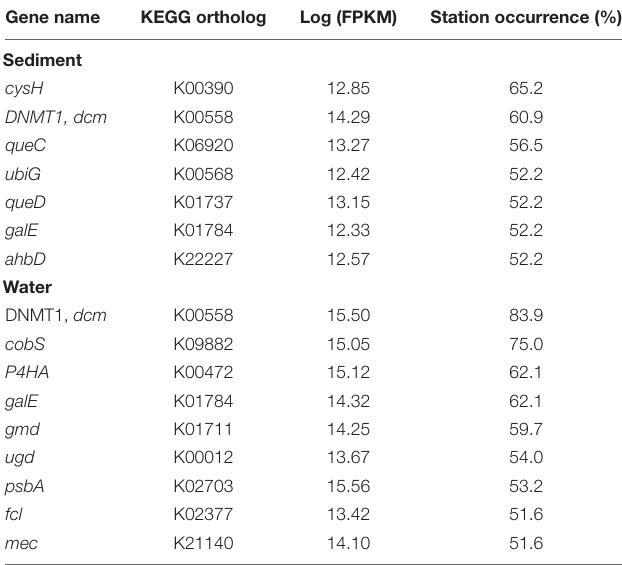
TABLE 1 | Most abundant KEGG orthologs with assigned metabolic pathway, the sum of assigned FPKM, and occurrence (% samples) in which the KEGG orthologs were